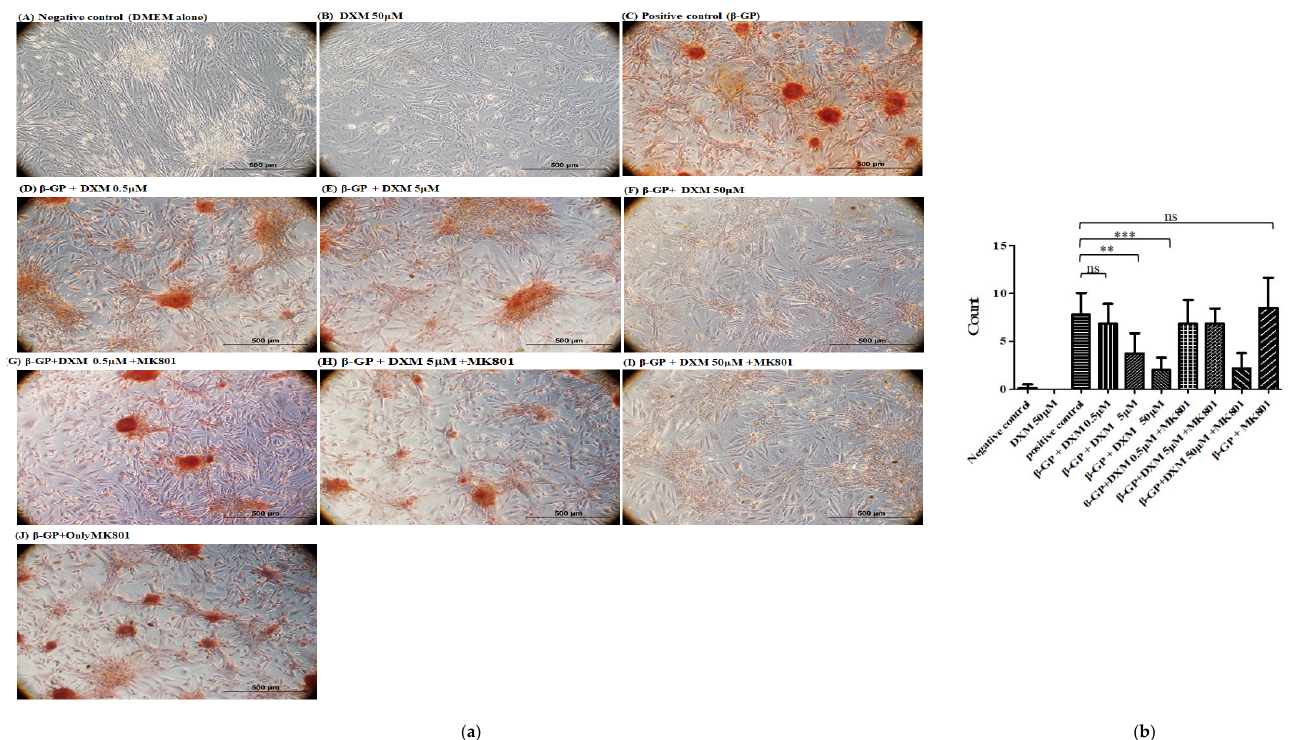
Figure 2. Effects of DXM plus N -methyl- D -aspartate receptor antagonist on vascular smooth muscle cells with the high- phosphate medium. ( a ) Alizarin red S staining was employed to assess calcification in the vascular smooth muscle cells. Scale bar, 500 µ m. ( b ) Statistical analysis of calcification on each group. Not significant: ns, ** p < 0.01, *** p <